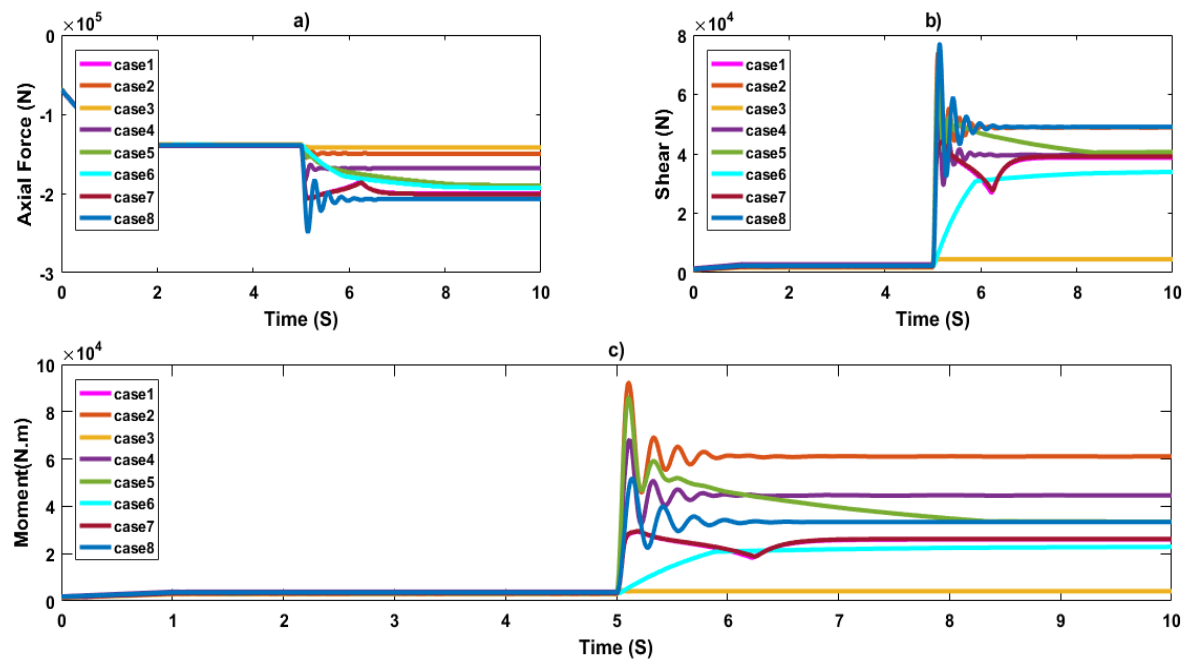
Figure 22. Column behavior after column removal in story six: ( a ) axial force, ( b ) shear, and ( c ) moment.